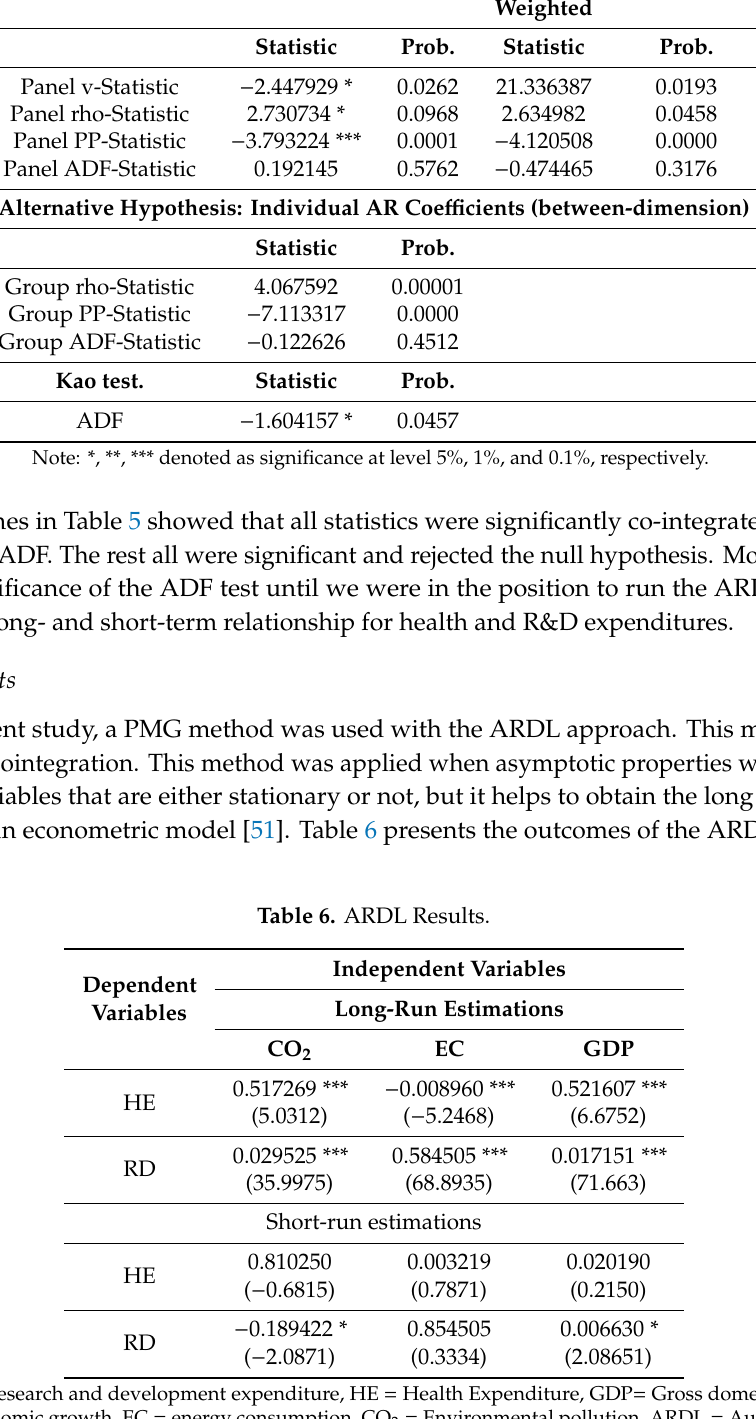
Table 5. Co-Integration Analysis.